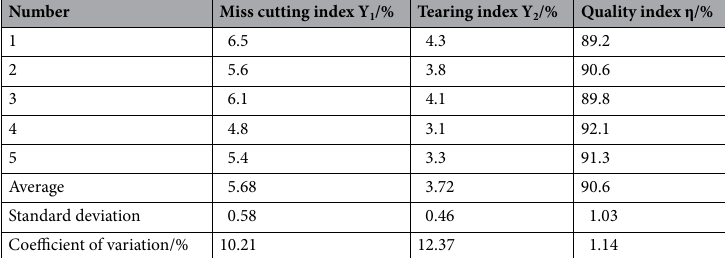
Table 4. Optimal case experiment results